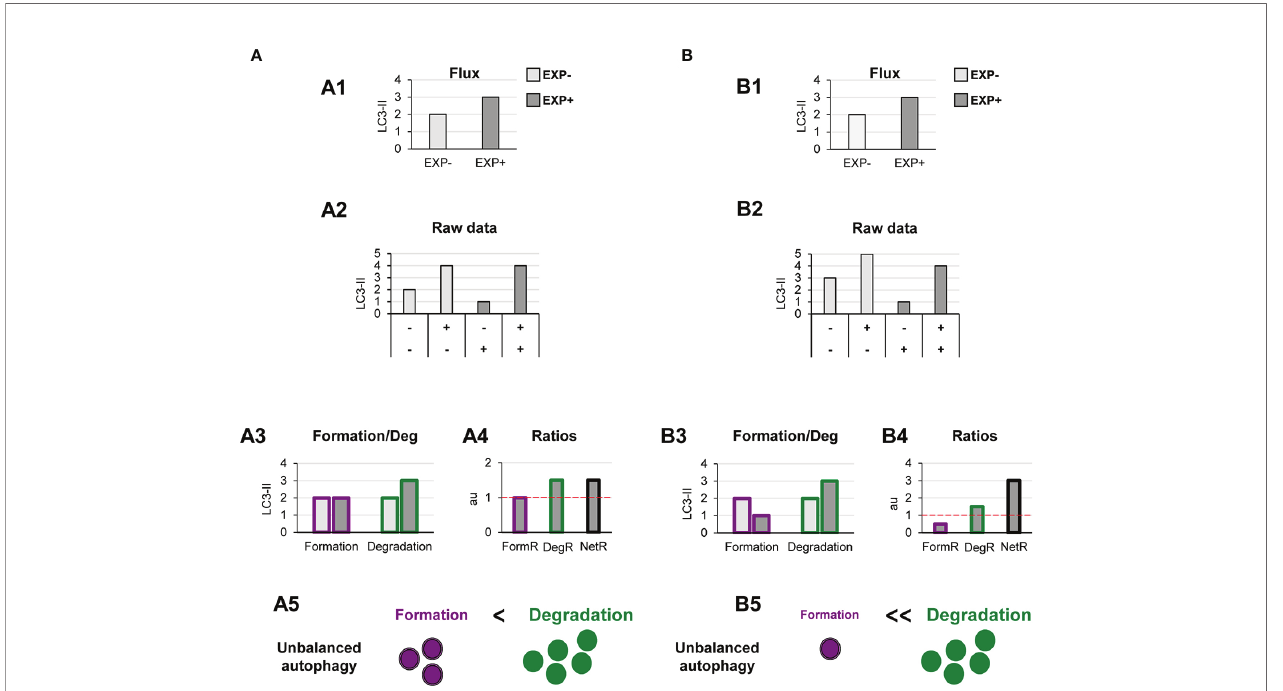
FIGURE 4 | Theoretical examples of increased autophagosome degradation that lead to unbalanced autophagy. (A, B) show examples with similar conventional fl ux (A1, B1), derived from apparently similar raw LC3-II/actin Western blot data (A2, B2). In (A) our model would reveal an increased autophagosome degradation rate and no changes in the formation rate (A3), leading to an increased degradation ratio and net ratio (A4), and an unbalanced autophagy (A5). In contrast, in (B) our model would reveal decreased autophagosome formation rate but increased degradation (B3), leading to decreased formation ratio, increased degradation ratio, and a strong increase in the net ratio (C4), ultimately resulting in a highly unbalanced autophagy